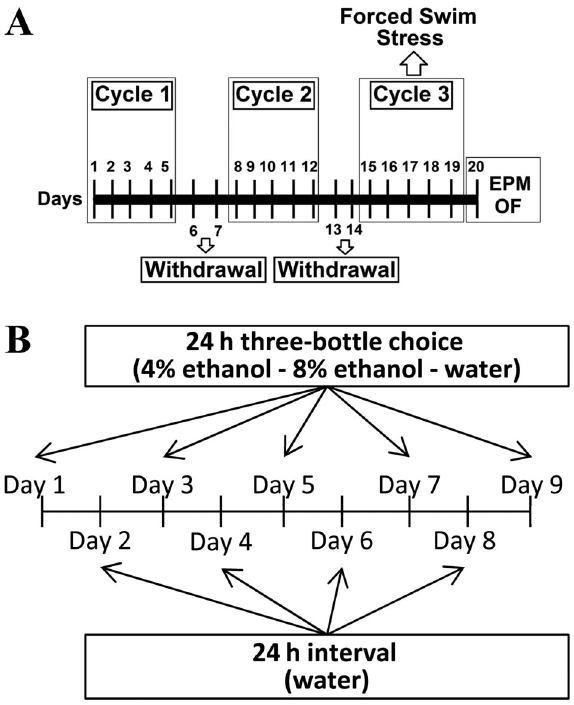
Figure 1. A , Procedural timeline for chronic administration of ethanol and stress testing. B , Experimental protocol used for voluntary consumption of ethanol. EPM: elevated plus maze; OF: open fi